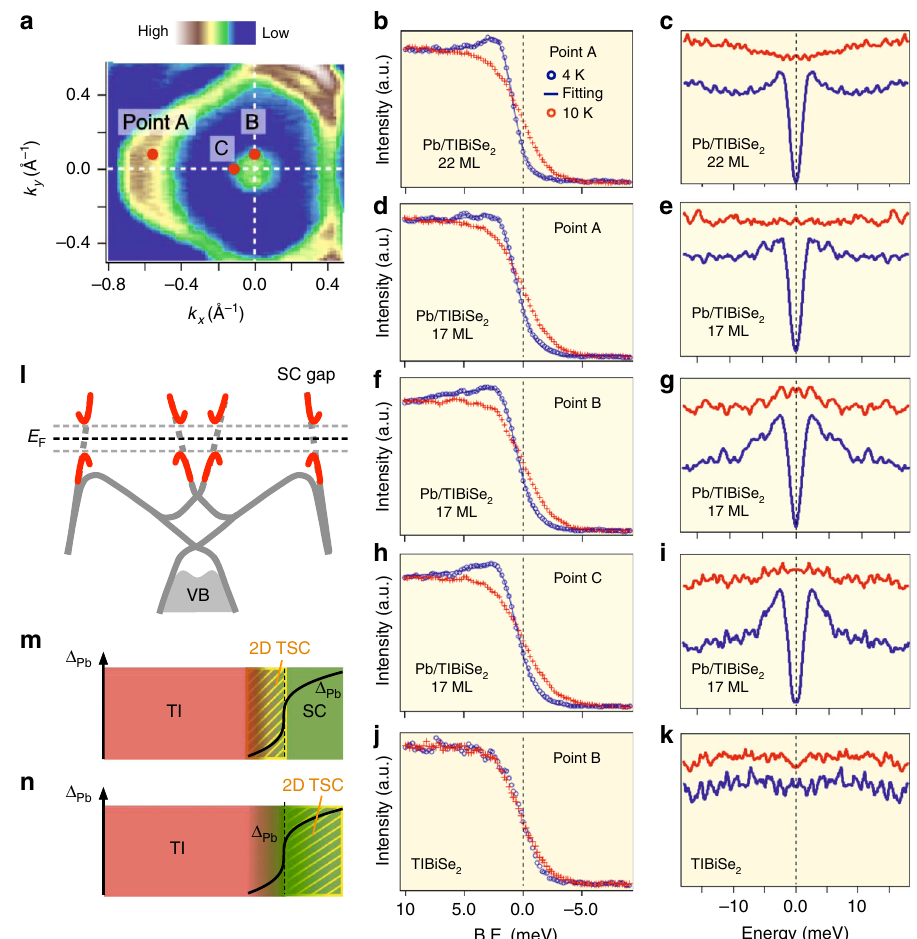
Fig. 3 Possible topological superconductivity in Pb fi lm. a ARPES-intensity mapping at E F for 22ML-Pb/TlBiSe 2 . b , c Ultrahigh-resolution EDCs and corresponding symmetrized EDCs, respectively, at T = 4 and 10 K, measured at point A in a ( k F point of the QWS) for 22ML-Pb/TlBiSe 2 . d , e Same as b and c , respectively, but for 17ML-Pb/TlBiSe 2 . f , g Same as d and e , respectively, but measured at point B ( k F point of the topological SS). h , i Same as d and e , respectively, but measured at point C. j , k Same as f and g , respectively, but for pristine TlBiSe 2 . Blue solid curve in the EDC at T = 4 K in b , d , f , and h is the result of numerical fi ttings using the Dynes function multiplied by the Fermi – Dirac distribution function, convoluted with a resolution function. l Illustration of the superconducting-gap opening on the QWS- and TSS-derived bands. m Conventional view on the realization of 2D TSC via SPE. n Proposed method to realize 2D TSC by converting a conventional superconductor into a TSC through the